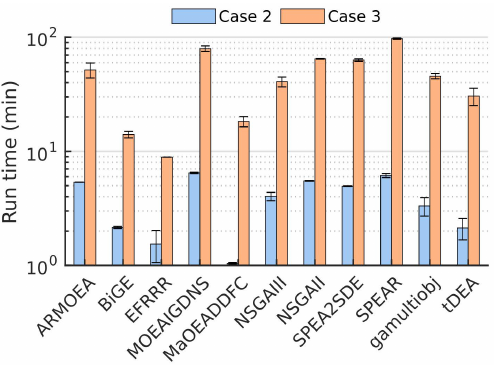
Figure 5. Wall-clock run times for the 10-objectives design problem with population sizes of 100 (Case 2) and 1000 (Case